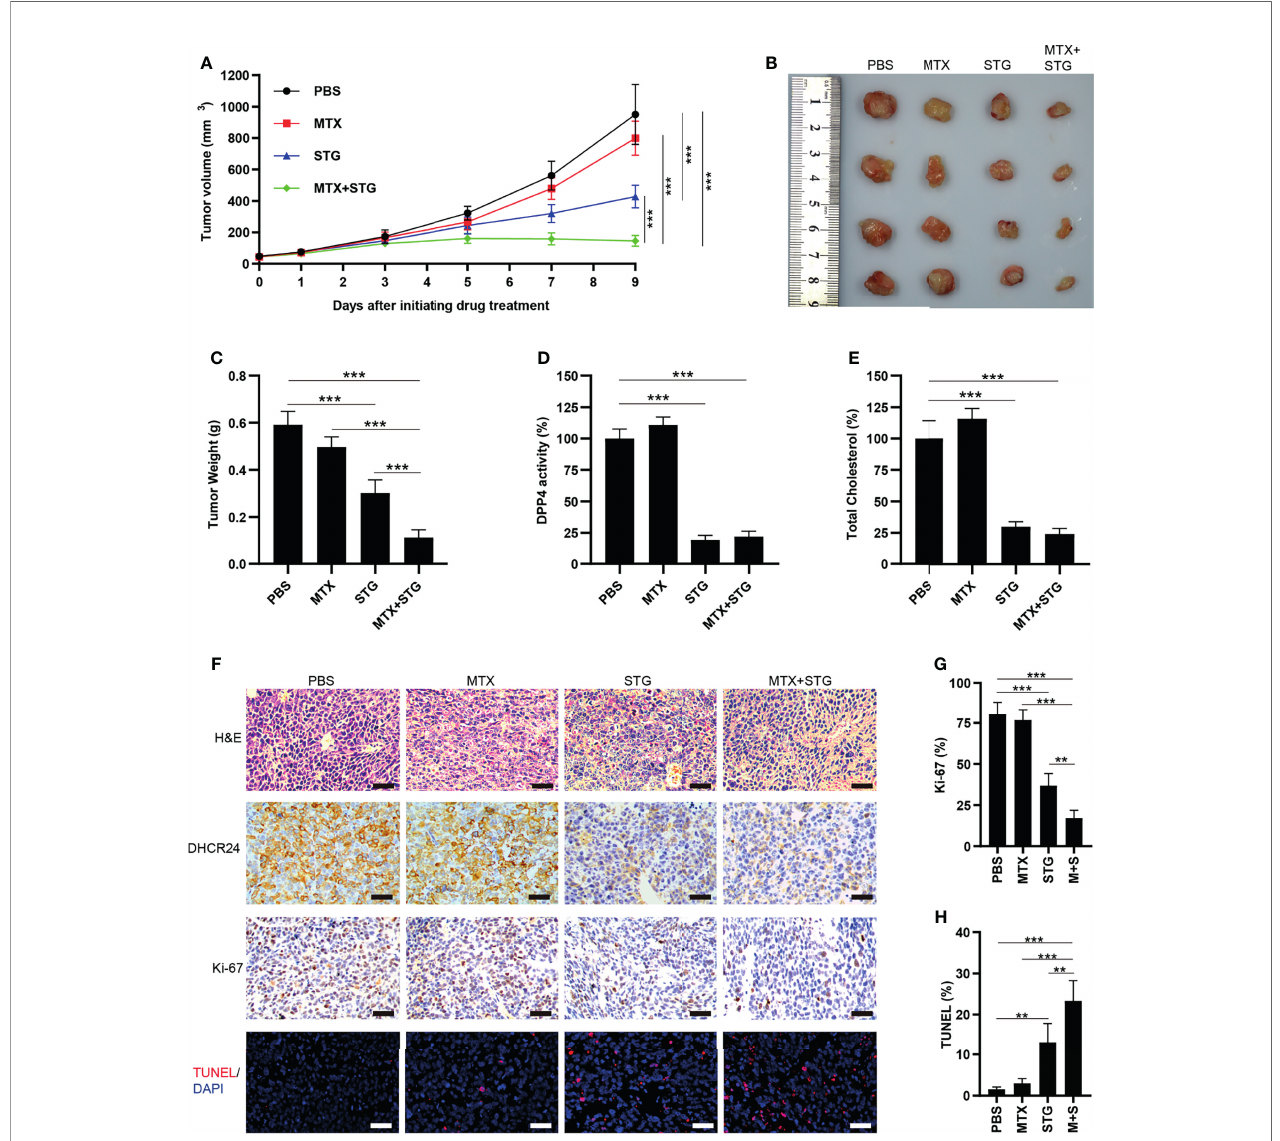
FIGURE 8 | The effect of sitagliptin on cholesterol biosynthesis, DHCR24 expression and tumor growth in JAR/MTX xenograft model. (A) Sitagliptin alone or sitagliptin +MTX effectively suppressed the growth of subcutaneous JAR/MTX xenografts in vivo . n=4, ***P<0.001. (B, C) Sitagliptin alone or sitagliptin+MTX markedly reduced the weight of JAR/MTX xenografts. n=4, ***P<0.001. (D, E) Sitagliptin alone or sitagliptin+MTX markedly reduced DPP4 enzymatic activity and cholesterol level in JAR/ MTX xenograft tissues. ***P<0.001. (F) Immunostaining of the JAR/MTX xenografts after drug treatment. The tissue sections were immunostained with primary antibodies (DHCR24 and Ki-67) or labeled by TUNEL. Bars: 100 m m. (G, H) The positivity of Ki-67 and TUNEL labeling in each group. n=4, **P<0.01;